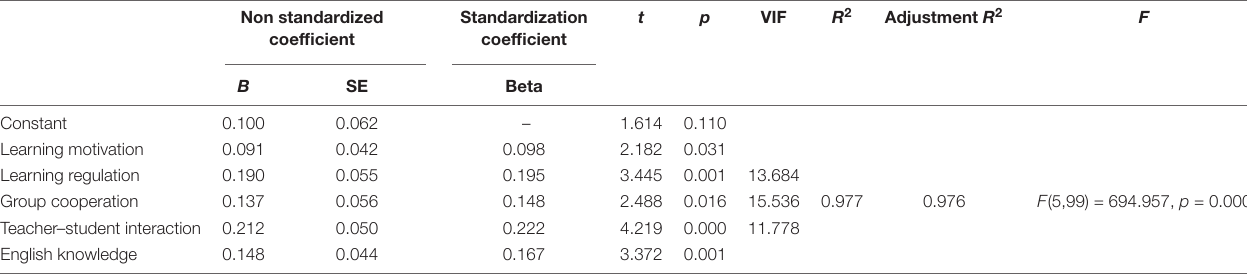
TABLE 3 | Stepwise regression results of factors influencing emotional engagement of non-English majors.